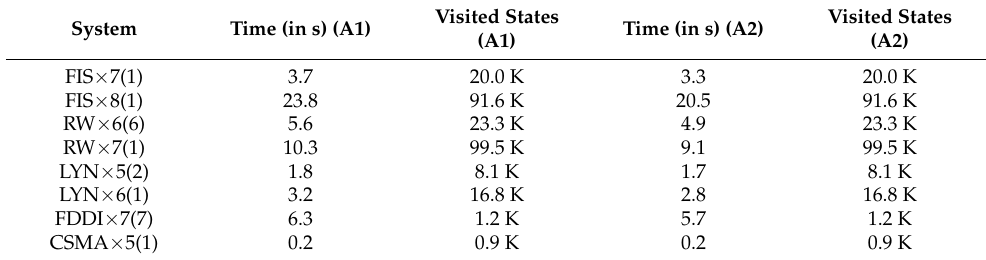
Table 1. Tests on the algorithms with benchmark